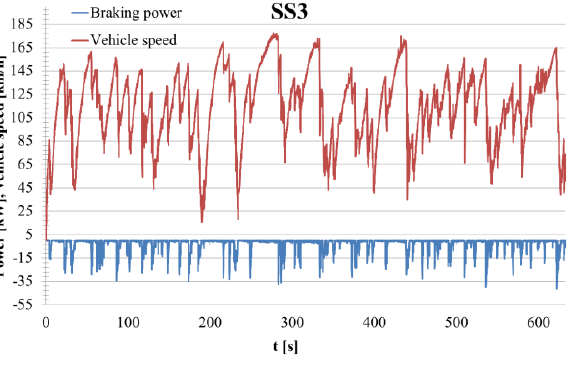
Fig. 8. Braking energy in SS2